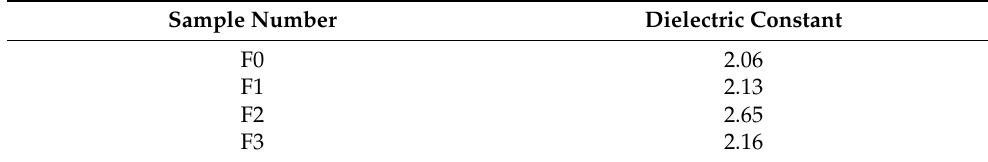
Figure 6. Dielectric constant test platform. Table 2. Dielectric constant of modified sample.